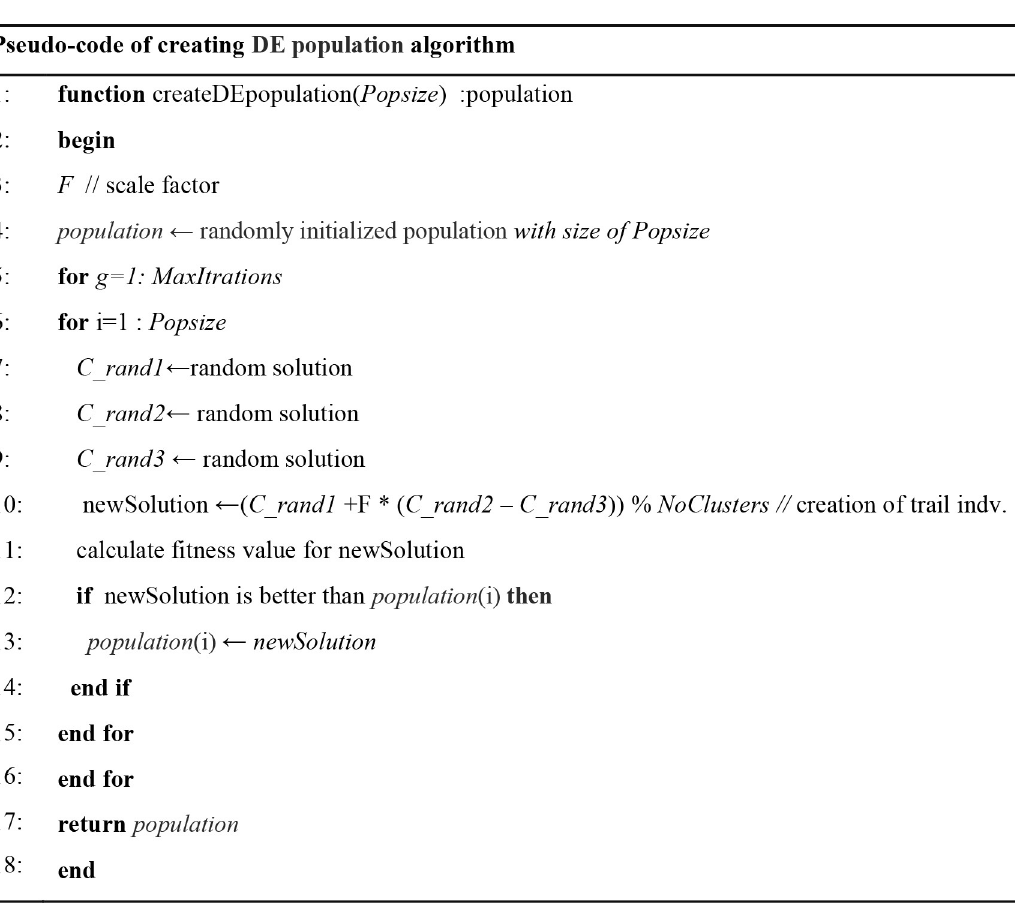
Fig 12. Pseudo-code of creating DE population